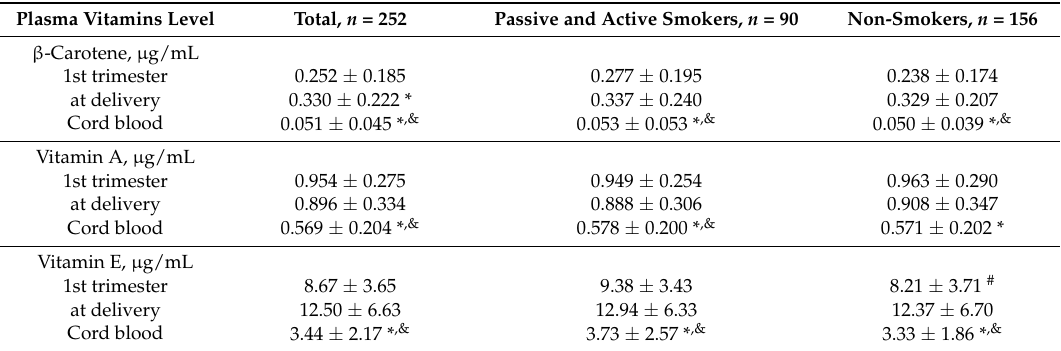
Table 3. β -Carotene, vitamin A and E concentrations in plasma in the pregnant women in the 1st trimester, at delivery and in umbilical cord plasma.